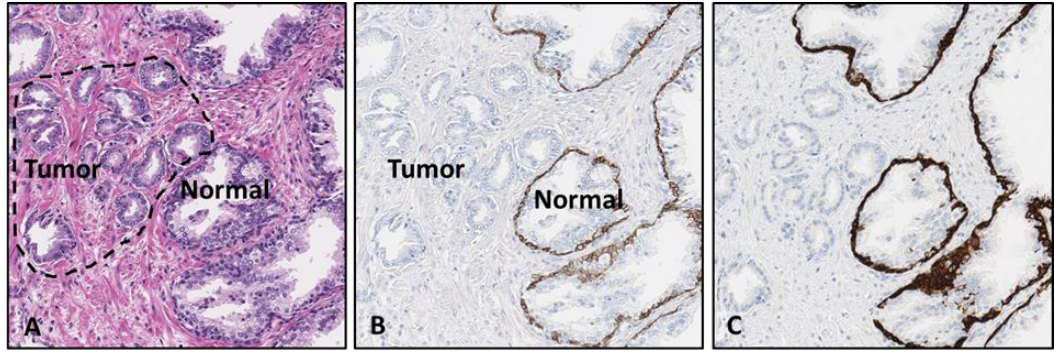
Figure 1 . Malignant primary prostate adenocarcinoma tissue sample. The first image shows the prostate tissue stained with H&E ( A ). The areas with tumor and normal prostate gland tissue are labeled. The H&E stained tissue slide was de-stained and anti-CK5 / 14 mouse monoclonal antibody cocktail was applied to determine feasibility of the proposed protocol ( B ). A sequential sample slide was stained with the same anti-CK5 / 14 marker using a standard protocol procedure (right panel), for comparison of stain intensity to initial de-stain / re-stain procedure results ( C ). [10 × magnification].